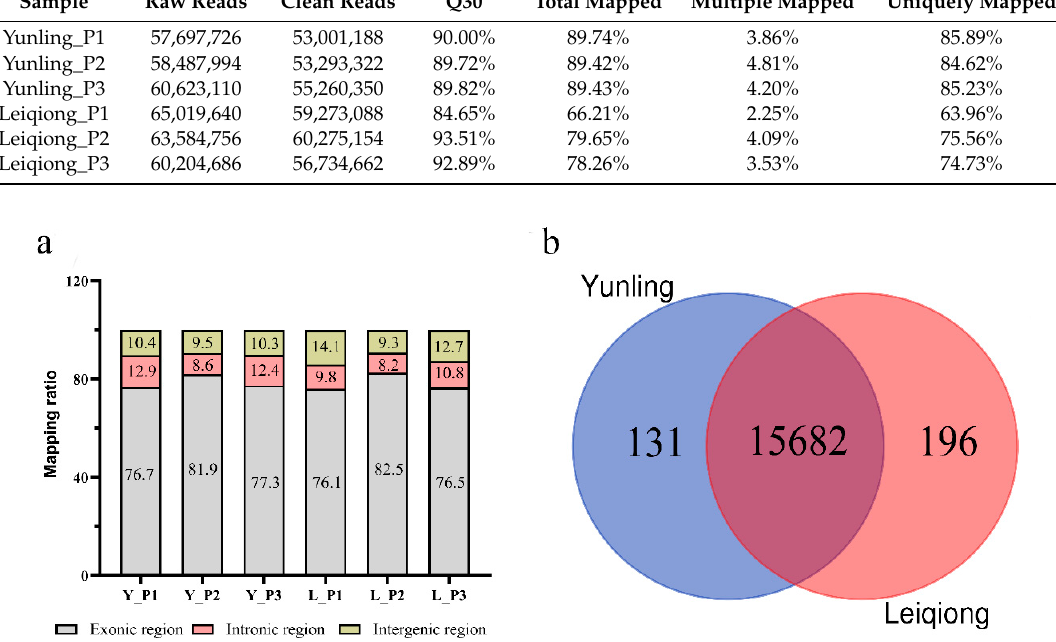
Figure 2. Genome alignment profiles. ( a ) The percentage of reads mapping to indicate genomic regions: exonic (gray), intronic (red), intergenic (yellow). ( b ) Venn diagram depicting the co-expressed (purple region) and uniquely expressed genes (blue region and red region) discovered in the pituitary glands of the two cattle breeds.